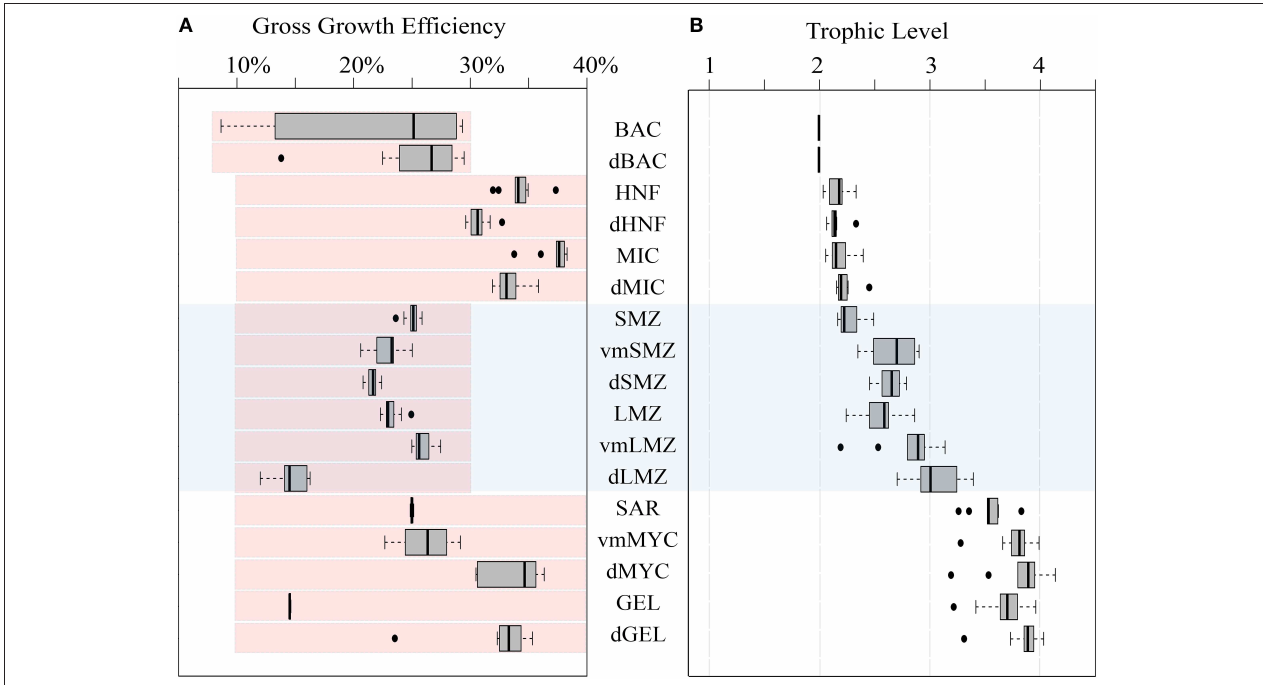
FIGURE 4 | (A) Box and whisker plot of GGE for organisms in the LIEM. Red shaded boxes indicate the permitted range of values constraining the LIEM. (B) Box and whisker plot of trophic levels for each zooplankton assuming detritus and primary productivity are trophic level 1, and bacteria are trophic level 2. Box and whisker plots show inter-quartile range and 95% C.I. as determined using the mean solutions for each cycle. For reference the mesozooplankton compartments are shaded across both figures. Abbreviations are explained in Table 2